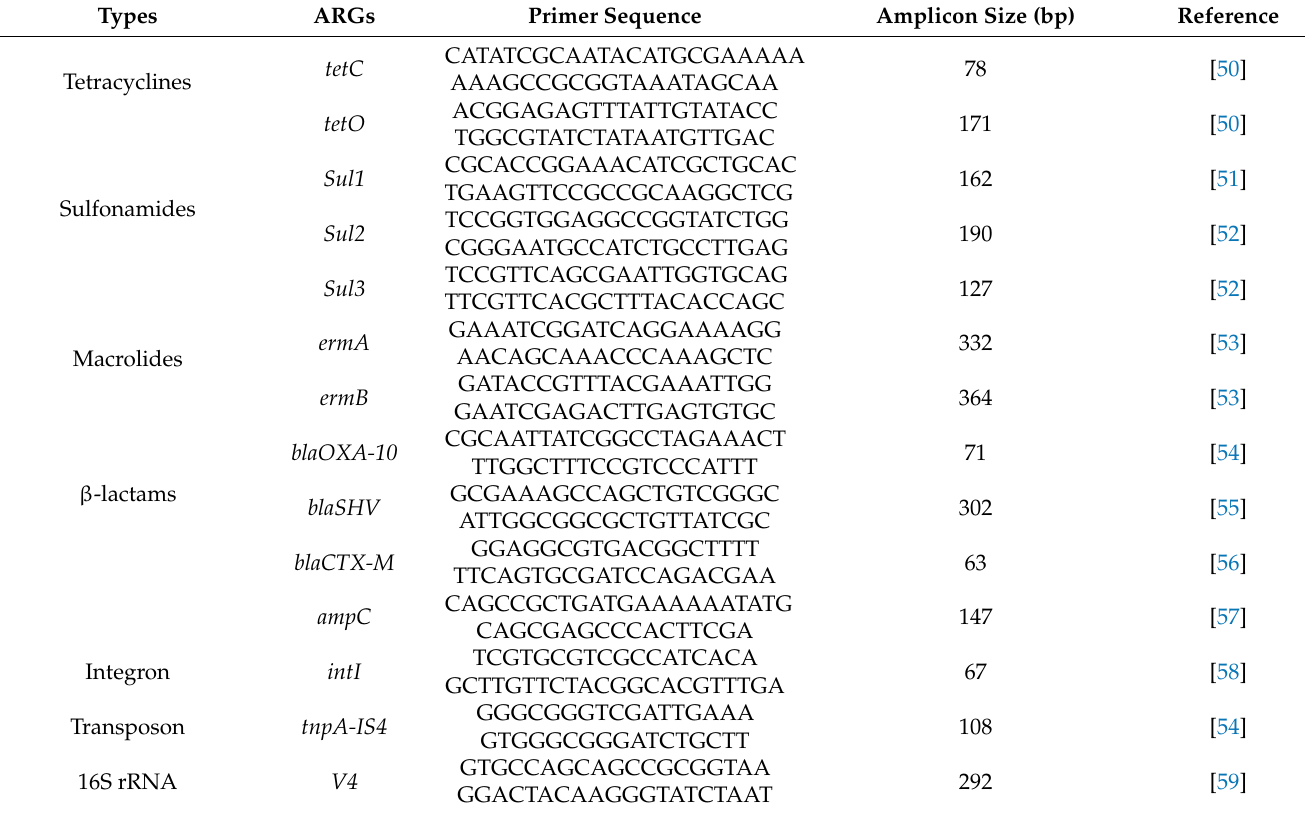
Table 4. PCR primers used for amplification of ARGs, class 1 integron, and